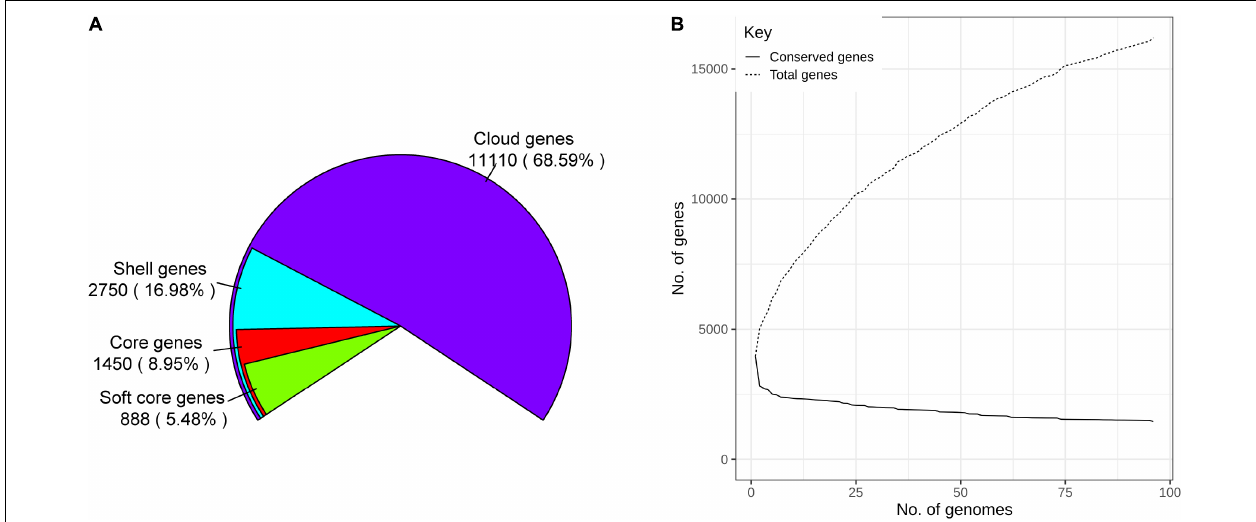
FIGURE 1 | Pan-genome of 96 B. amyloliquefaciens . (A) A pie chart of the breakdown of genes (core: 99% ≤ strains ≤ 100%, soft-core: 95% ≤ strains < 99%, shell: 15% ≤ strains < 95%, and cloud: 0% ≤ strains < 15%). (B) The pan-genome curve of the 96